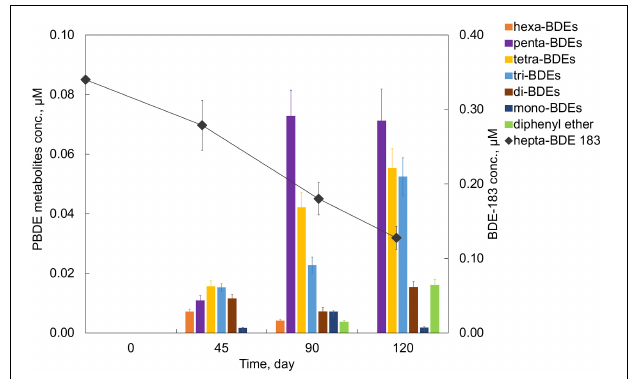
FIGURE 3 | Debromination of hepta-BDE 183 by PB enrichment